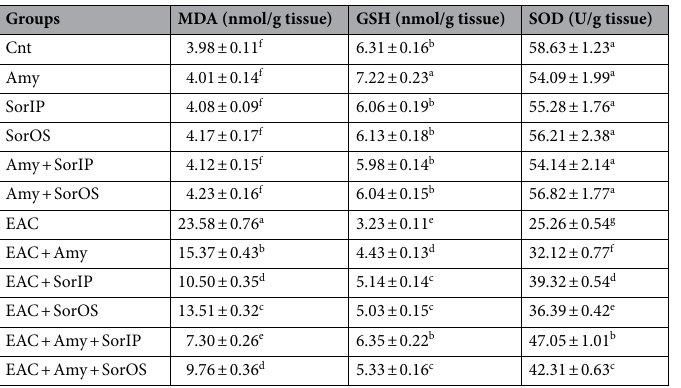
Table 3. Hepatic oxidative (MDA) and antioxidative (GSH and SOD) parameters in EAC-bearing mice after treatment with amygdalin and/or sorafenib. Data were presented as means ± SEM. Small (a–g) letters showed the marked change at P ≤ 0.05. The significant were expressed by dissimilar letters in the same